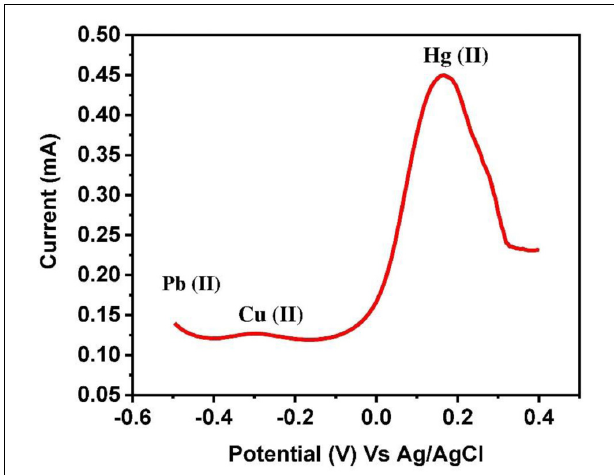
FIGURE 11 | Selective determination of Hg (II) ions from a Cu, Pb, and Hg ion-containing solution.